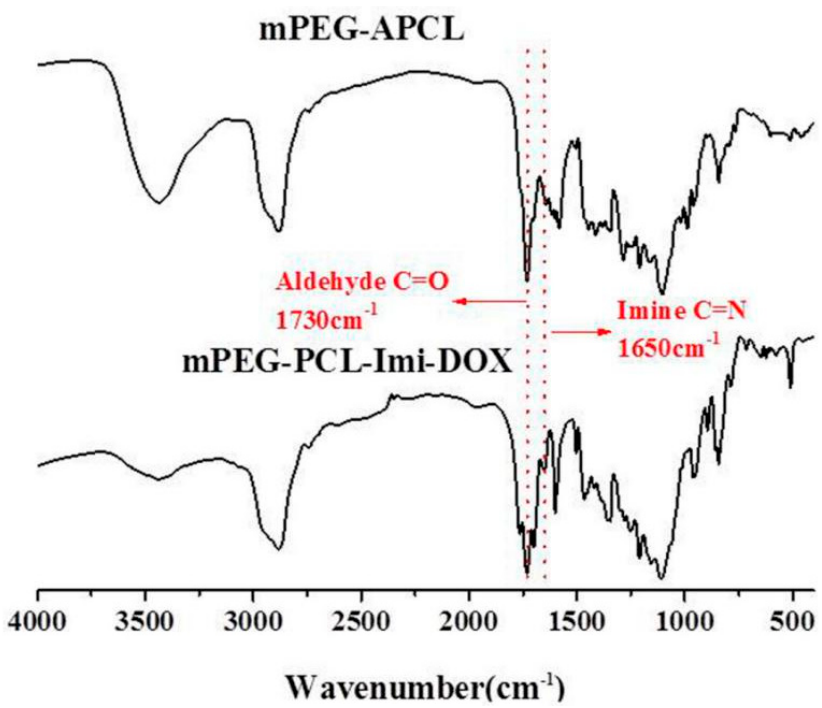
Figure 3. 1 H NMR spectrum of mPEG-PCL-Imi-DOX.